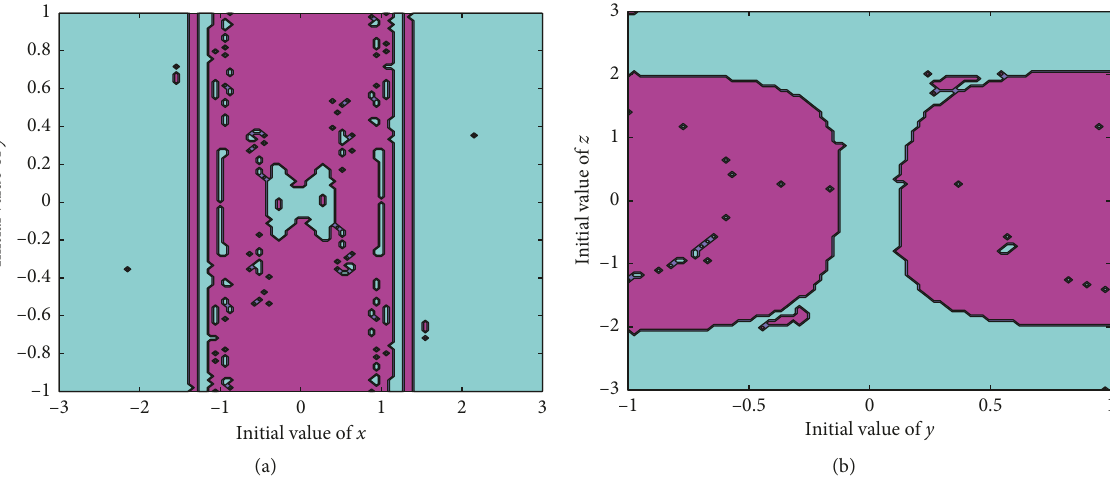
Figure 6: Dynamic distributions of system (1) with a � 3, b � − 1, c � 1: (a) x ( 0 ) versus y ( 0 ) with z ( 0 )� 0; (b) y ( 0 ) versus z ( 0 ) with x ( 0 )� 0.1. The chaotic regions are shown in cyan and the periodic regions are shown in